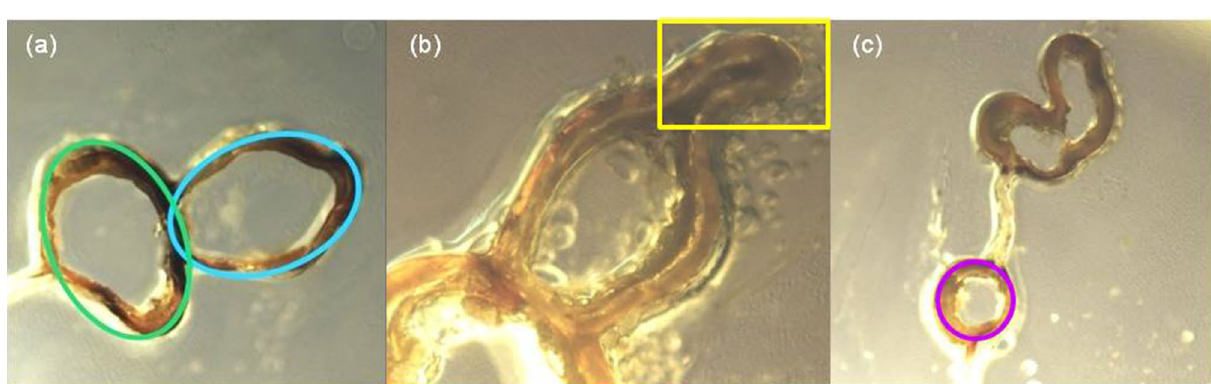
Figure 3. The Cicada 1 wing leading-edge cross section. Images: ( a ) a cross section with the costa and the subcosta approximated by ellipses (blue and green, respectively), ( b ) a cross section with the costa tip located within the area marked by yellow line, ( c ) a cross section with the marked internal vein (purple